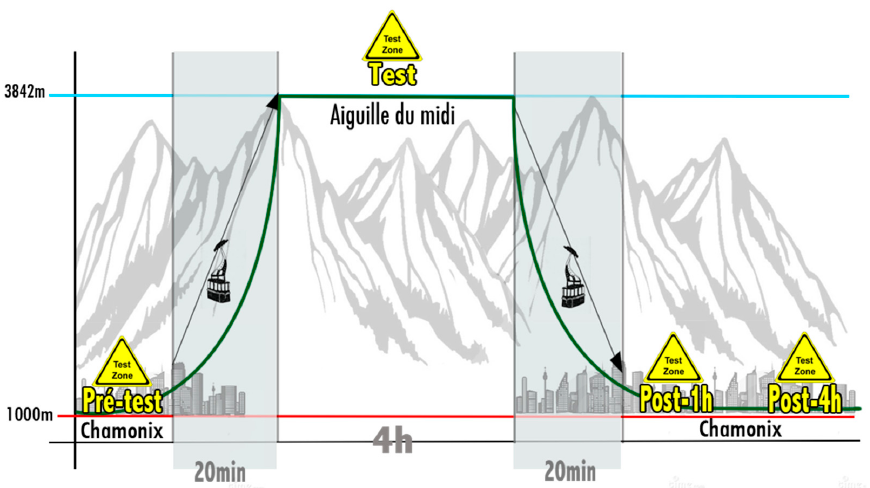
Figure 2. Changes in altitude during experiment. Measurements were taken at sea level, at 3842 m and 1 h after return to sea